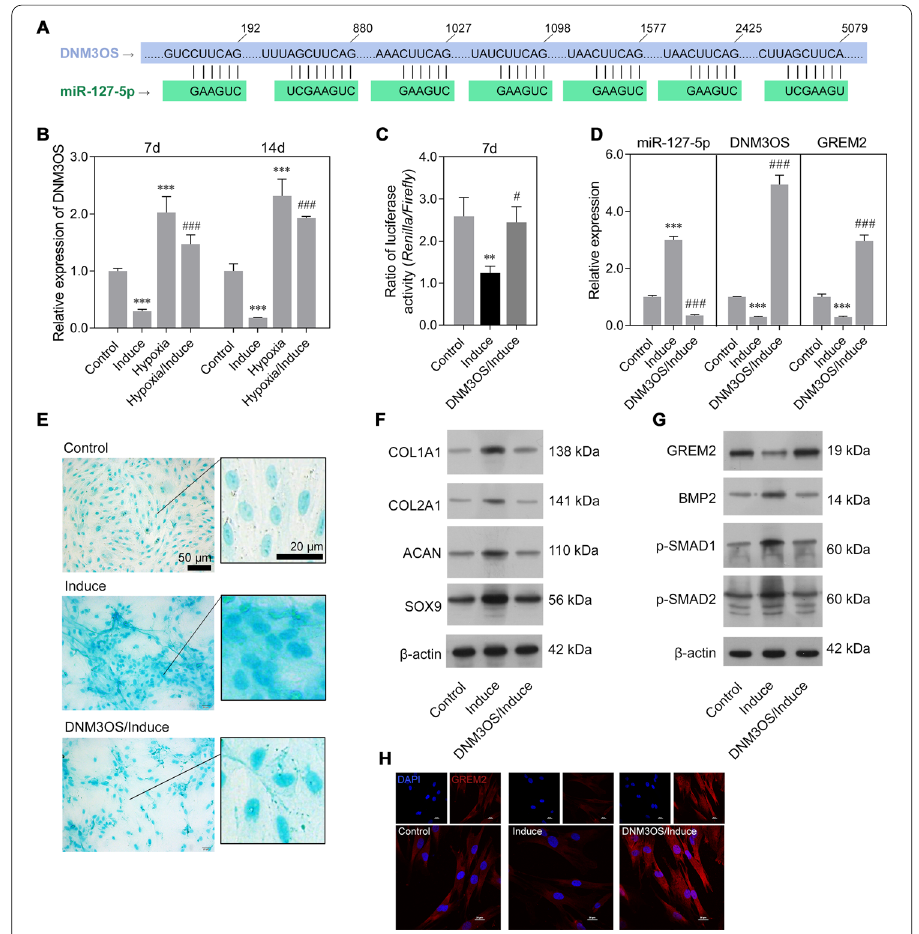
Fig. 6 DNM3OS inhibited chondrogenic differentiation of rMSCs via miR-127-5p regulation of GREM2. The rMSCs were transfected with a DNM3OS overexpression plasmid, followed by induction of chondrogenic differentiation for 14 days. Accordingly, the rMSCs were classified into control, induction, hypoxia, hypoxia/ induction, and DNM3OS/induction groups. A The putative binding site for miR-127-5p in the DNM3OS 3 ′ -UTR is shown. B DNM3OS expression was determined by quantitative real-time PCR analysis. C A luciferase reporter assay was performed to identify direct action between DNM3OS and the GREM2 3 ʹ -UTR. D Levels of DNM3OS, miR-127-5p, and GREM2 expression were determined by quantitative real-time PCR analysis. Results are expressed as mean standard deviation of data obtained from three independent experiments. ± ** p < 0.01, *** p < 0.001, compared with control; # p < 0.05, ### p < 0.001, compared with induction group; E Images from Alcian blue staining assays of rMSCs. (F) Levels of COL1A1, COL2A1, SOX9, and ACAN protein expression were detected in rMSCs. G Levels of GREM2, BMP2, p-SMAD1, and p-SMAD2 in rMSCs were detected by western blotting. H GREM2 protein expression in rMSCs was measured by